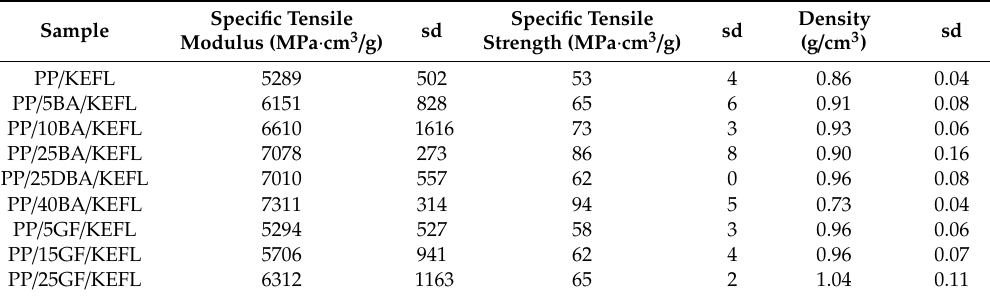
Table 4. Tensile analysis and density of the composites.